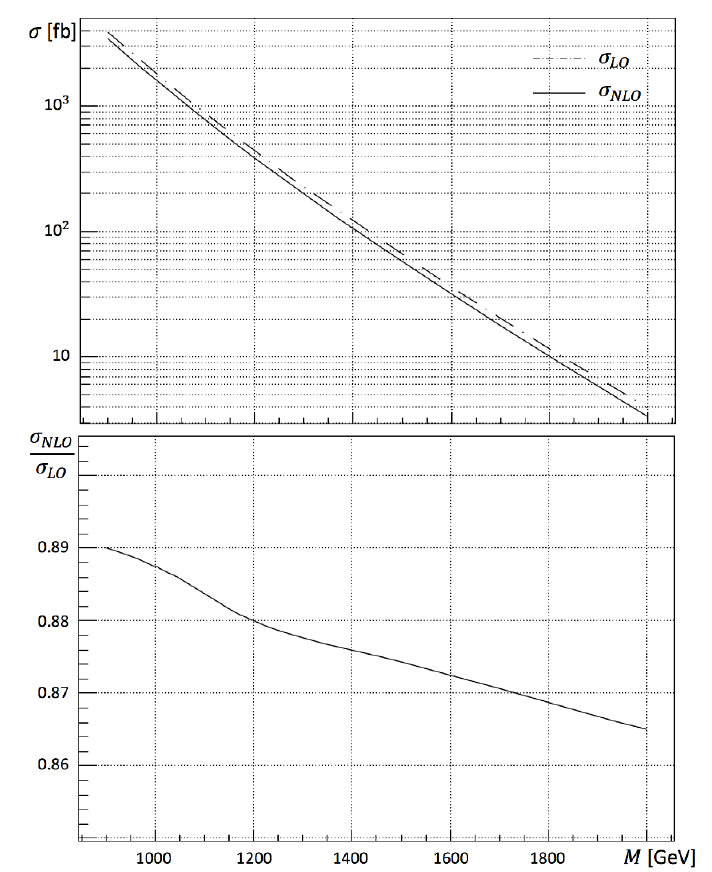
Figure 5 . Total LO and NLO coloron pair production cross-sections as function of the coloron mass p M , for s = 14 TeV and (cid:22) = (cid:22) F = M . The mass splitting between the colorons and P -odd quarks in the Born contribution has been set to the value predicted by mUED, see text and eq. (4.1), while the splitting has been neglected in the NLO corrections. The lower panel shows the ratio between NLO and LO